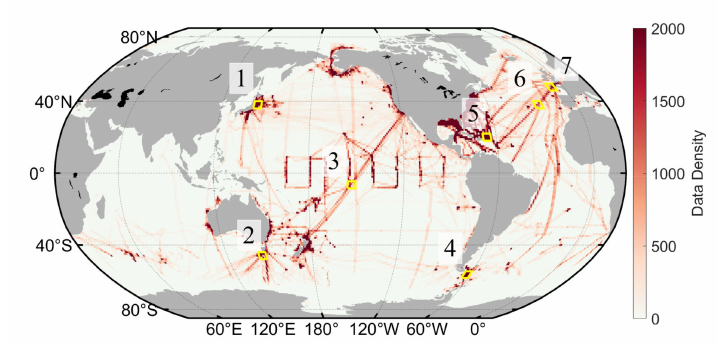
Figure 15. Density map of the calculated pH ( in situ *) data from 2004 to 2019, with a grid point size of 1 ◦ × 1 ◦ . The seven numbers represent the seven sea areas in Table 6. The seven yellow boxes are 4 ◦ (latitude) × 5 ◦ (longitude) grids for statistical